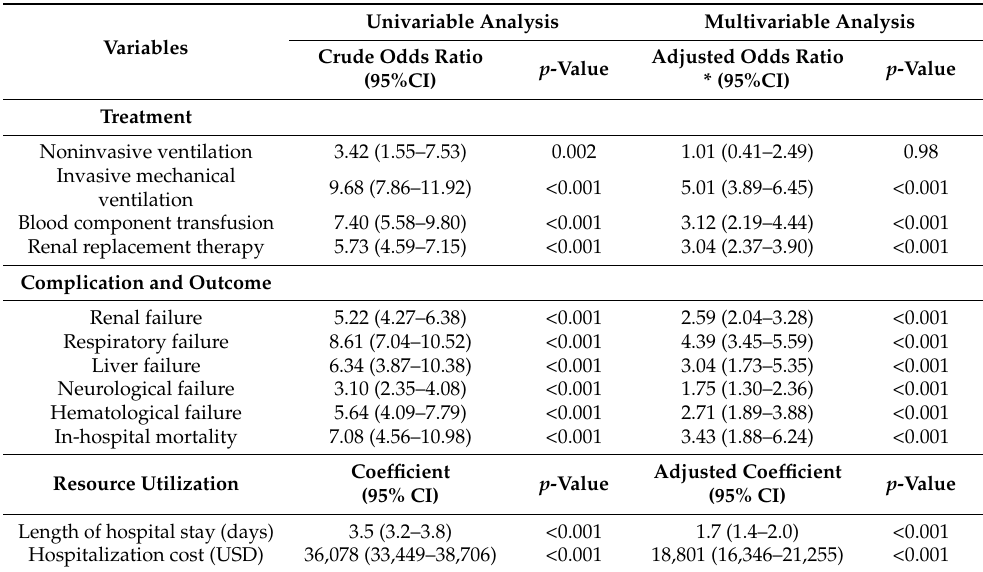
Table 3. The association of circulatory shock with in-hospital treatments, complications, outcomes, and resource utilization in salicylate intoxication